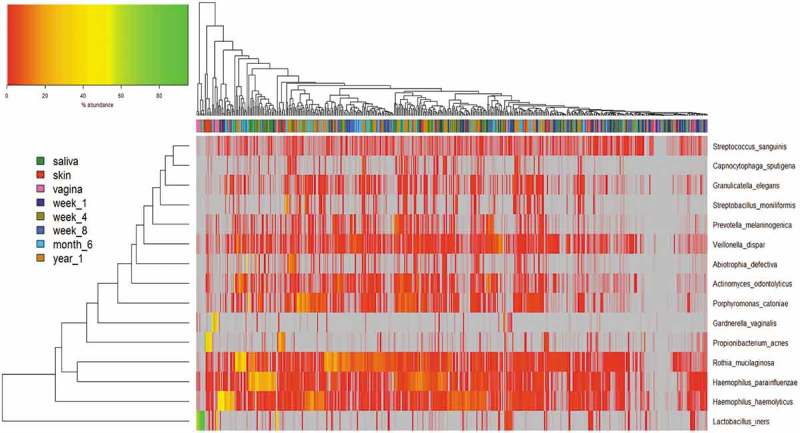
Hierarchical clustering of microbiota data at species level.